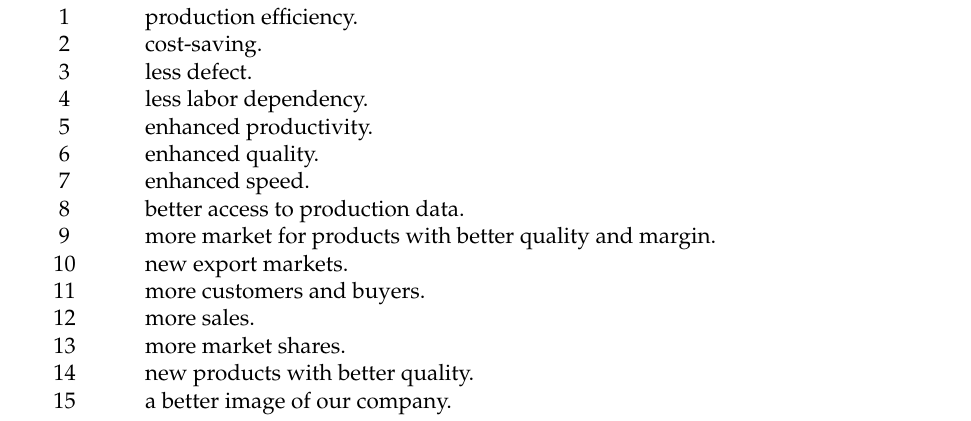
Table 5. Measurement items for perceived benefits and perceived opportunities. Adopting Industry 4.0 may result in . . .